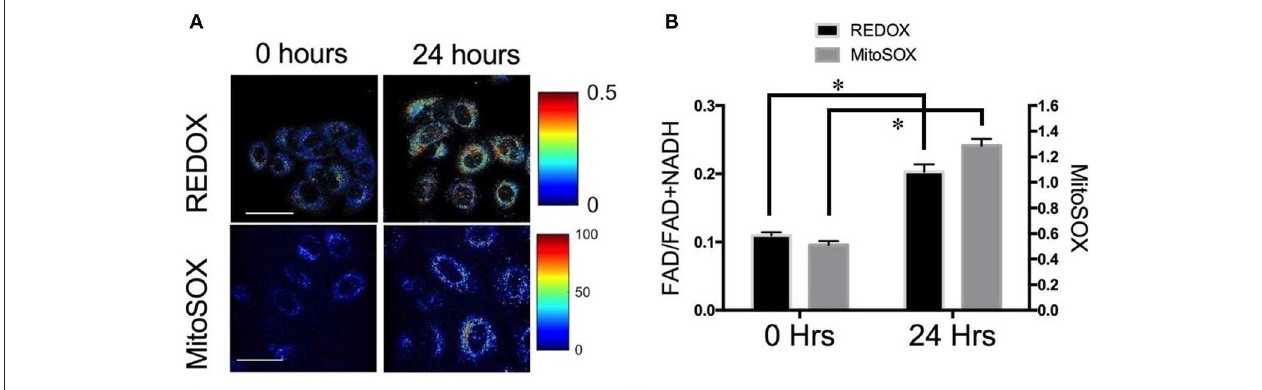
FIGURE 2 | Optical redox ratio (ORR) is sensitive to changes in reactive oxygen species (ROS) (A) Representative images and (B) quantification of redox ratio and MitoSOX, a fluorescent reporter of mitochondrial ROS illustrates significant differences before and 24h after treatment with YC-1. * p < 0.05. Adapted with permission from Lee et al.